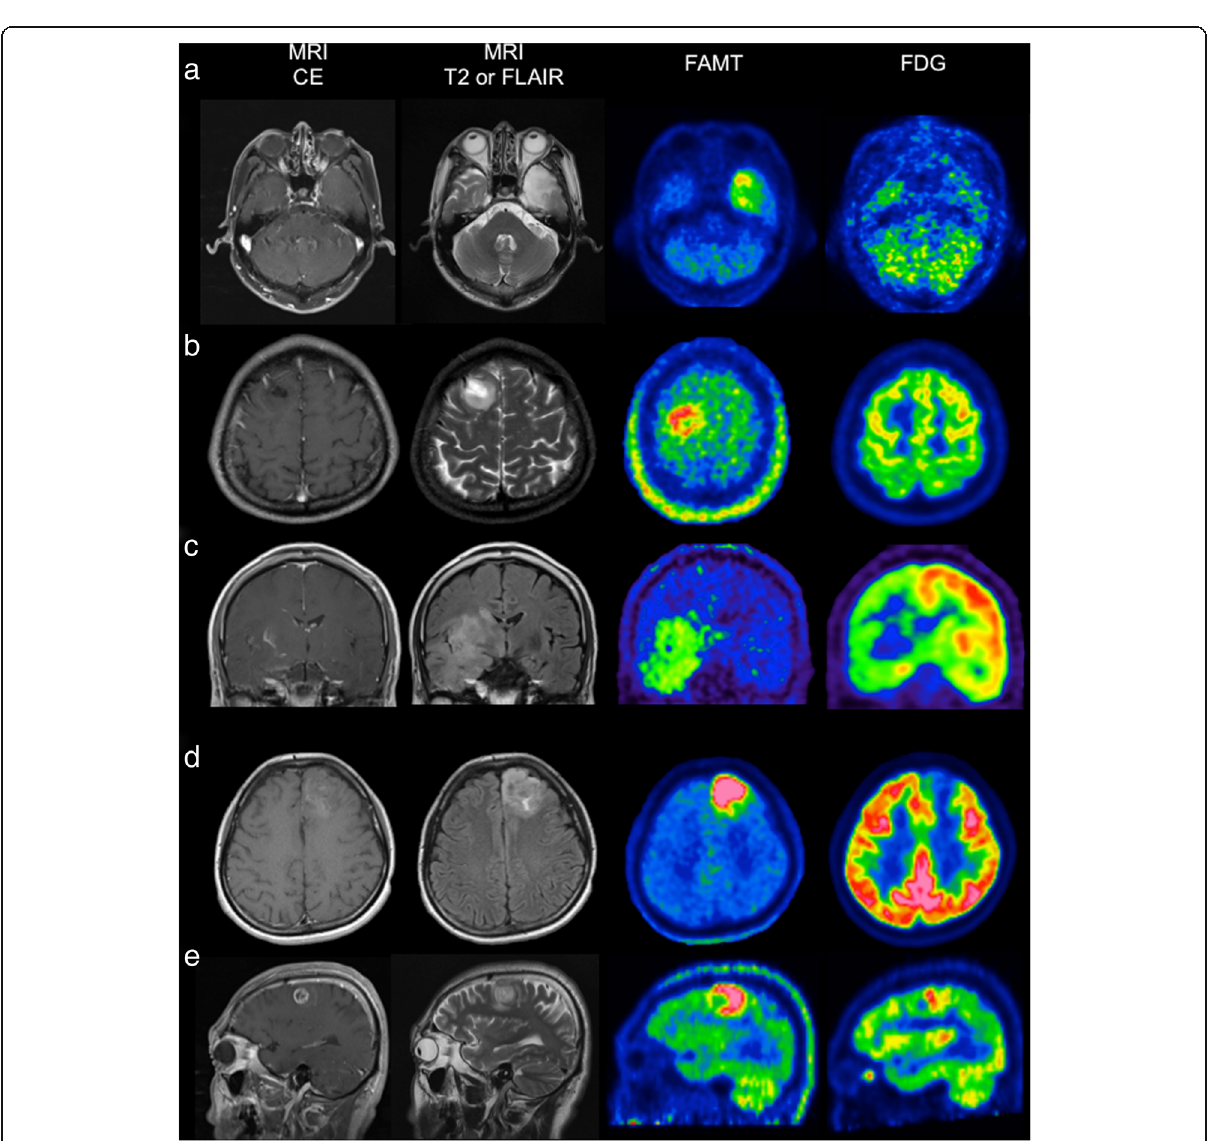
Fig. 5 Representative cases. Contrast-enhanced T1-weighted magnetic resonance images ( MRI CE ), T2-weighted or fluid attenuated inversion recovery images ( MRI T2 or FLAIR ), 18 F-FAMT PET images, and 18 F-FDG PET images, from left to right . a A 71-year-old man with diffuse astrocytoma. 18 F-FAMT T/N ratio was 2.05. 18 F-FDG T/N ratio was 0.90. b A 32-year-old man with oligoastrocytoma. 18 F-FAMT T/N ratio was 2.80. 18 F-FDG T/N ratio was 0.86. c A 50-year-old man with anaplastic astrocytoma. 18 F-FAMT T/N ratio was 5.33. 18 F-FDG T/N ratio was 1.22. d A 39-year-old woman with anaplastic oligoastrocytoma. 18 F-FAMT T/N ratio was 5.48. 18 F-FDG T/N ratio was 0.58. e A 56-year-old man with glioblastoma. 18 F-FAMT T/N ratio was 4.73. 18 F-FDG T/N ratio was